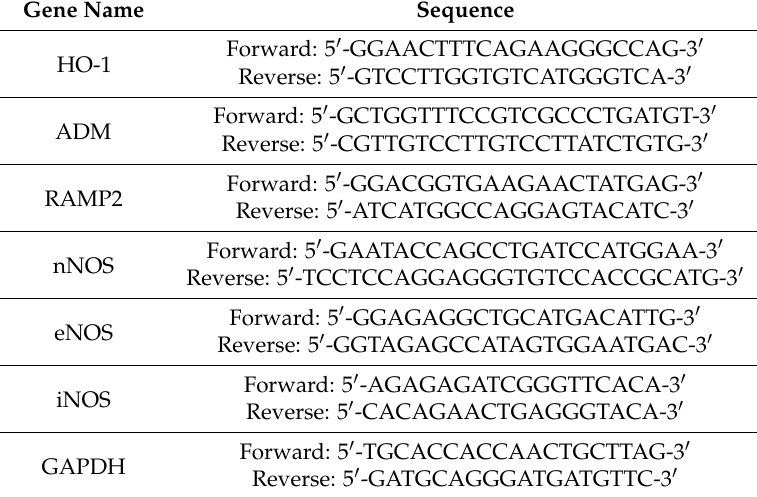
Table 1. Sequences of reverse transcription-polymerase chain reaction primers used in this